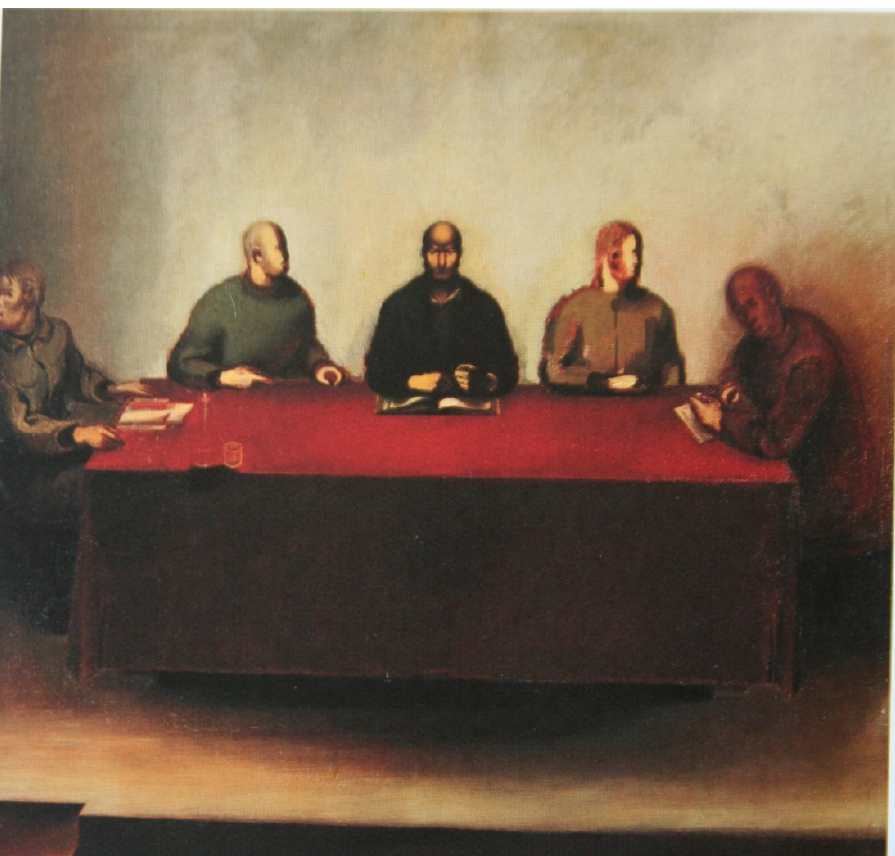
Figure 4. S. Nikritin. Judgment of the People . 1934.